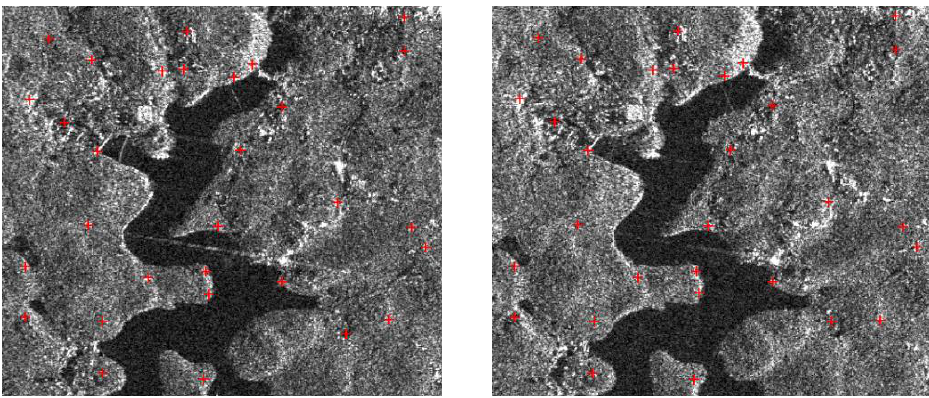
Figure5. Results of Test Image in Water